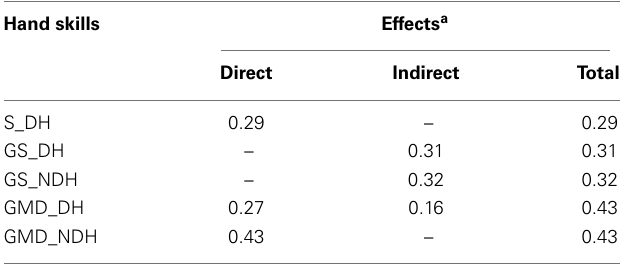
Table 5 | Direct, indirect, and total effects of hand skills on manual ability